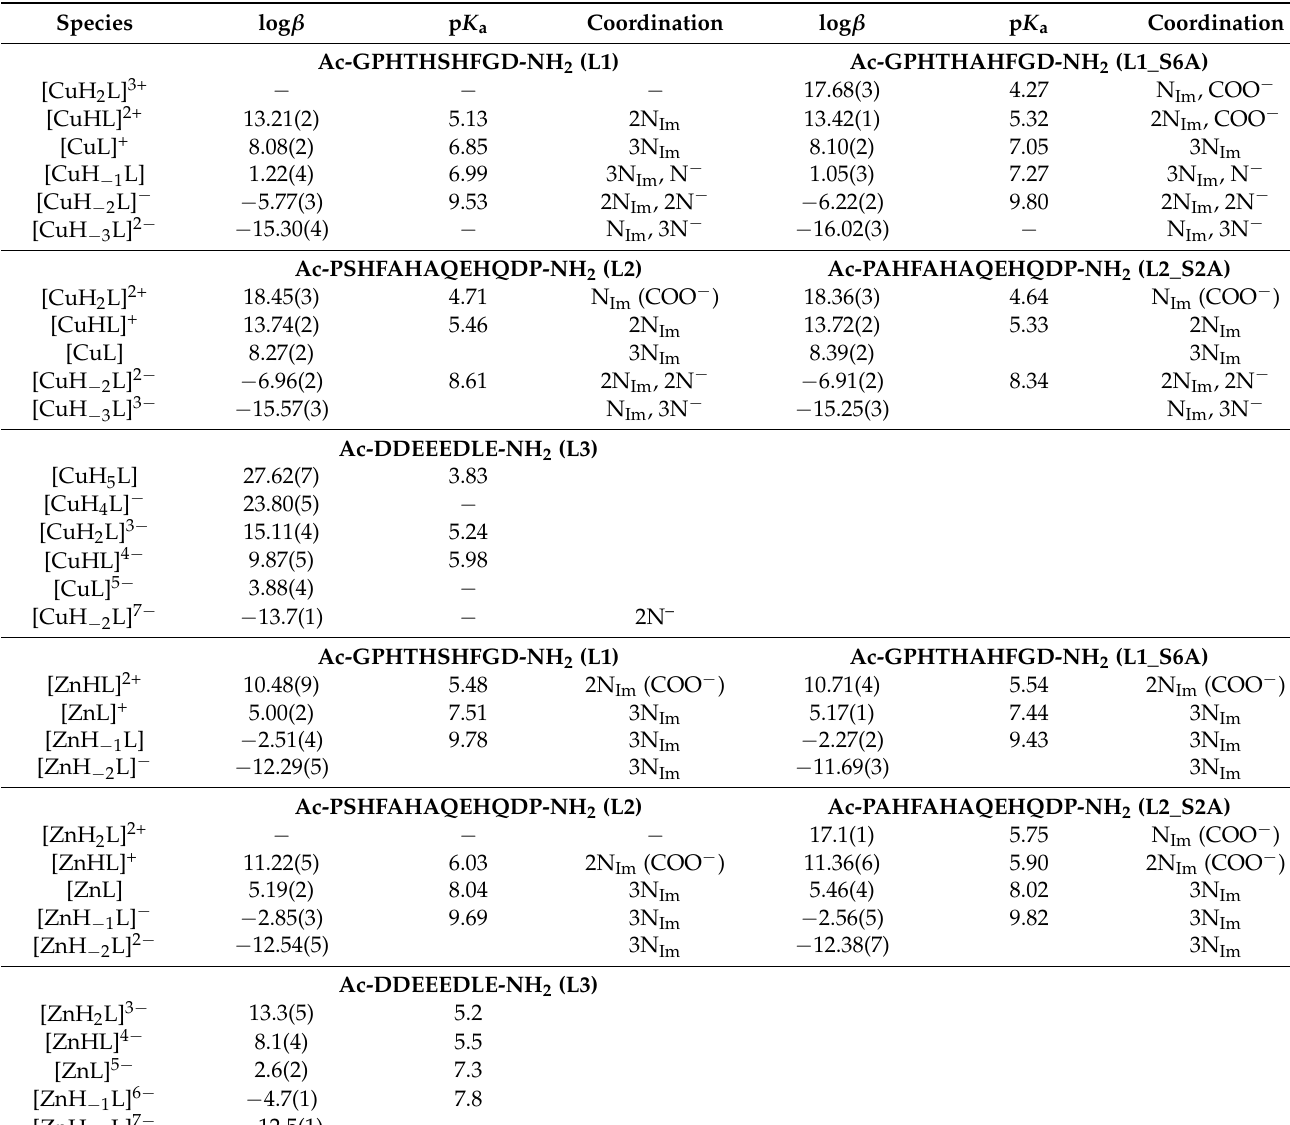
Table 2. Equilibrium constants and proposed coordination modes for Cu 2+ and Zn 2+ complexes at T = 298 K and I = 0.1 M (KCl). Values in parentheses are standard deviations on the last significant